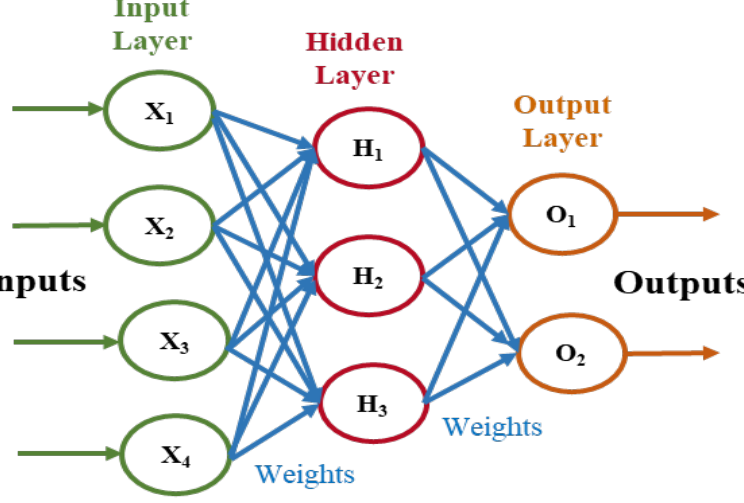
Figure 4. The basic architecture of the ANN model.